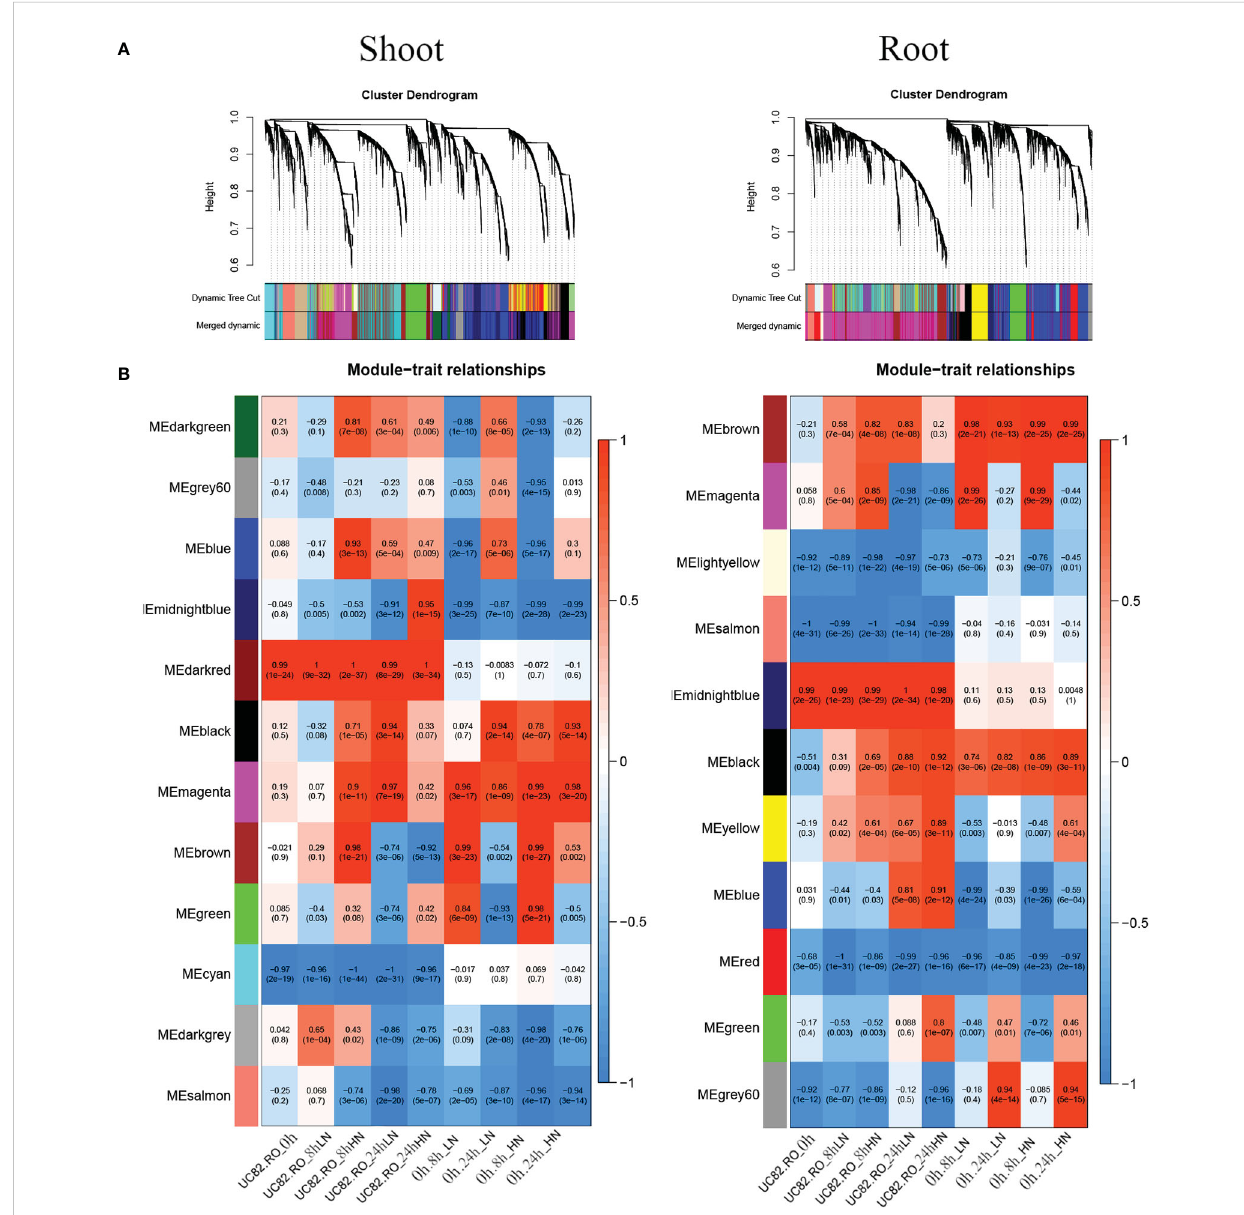
FIGURE 4 Merged clusters and dendrograms (A) and module – trait relationships (B) were obtained through the WGCNA analysis using 7,667 and 6,015 DEGs identi fi ed in shoot and root, respectively. In the heatmap, each Module Eigengene (ME) was correlated to each experimental condition. Inside each condition (0 h, 8 h-LN, 8 h-HN, 24 h-LN, 24 h-HN), the two genotypes were coded as RO (0) and UC82 (1) (columns 1 – 5), and ME were also correlated to each experimental condition regardless of the genotype (columns 6 –